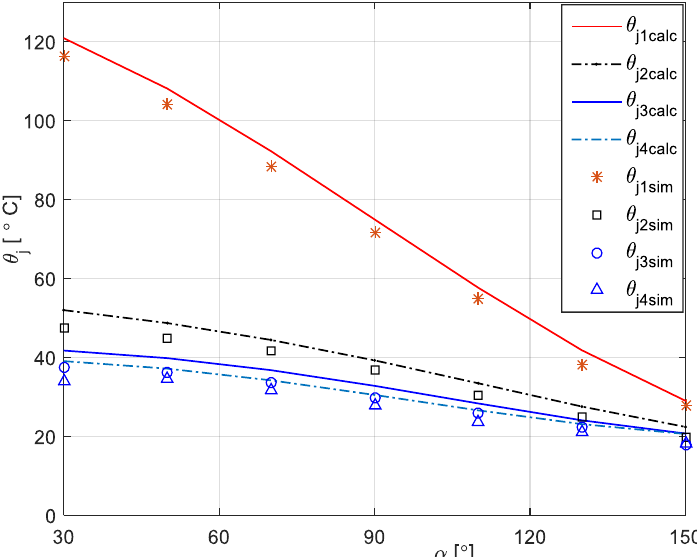
Figure 13. Junction temperature variation vs. firing angle at different load resistance values of 1.4, 5, 10, and 16 Ω ( v air = 3 m/s; I = 200 A; L = 30 mH).